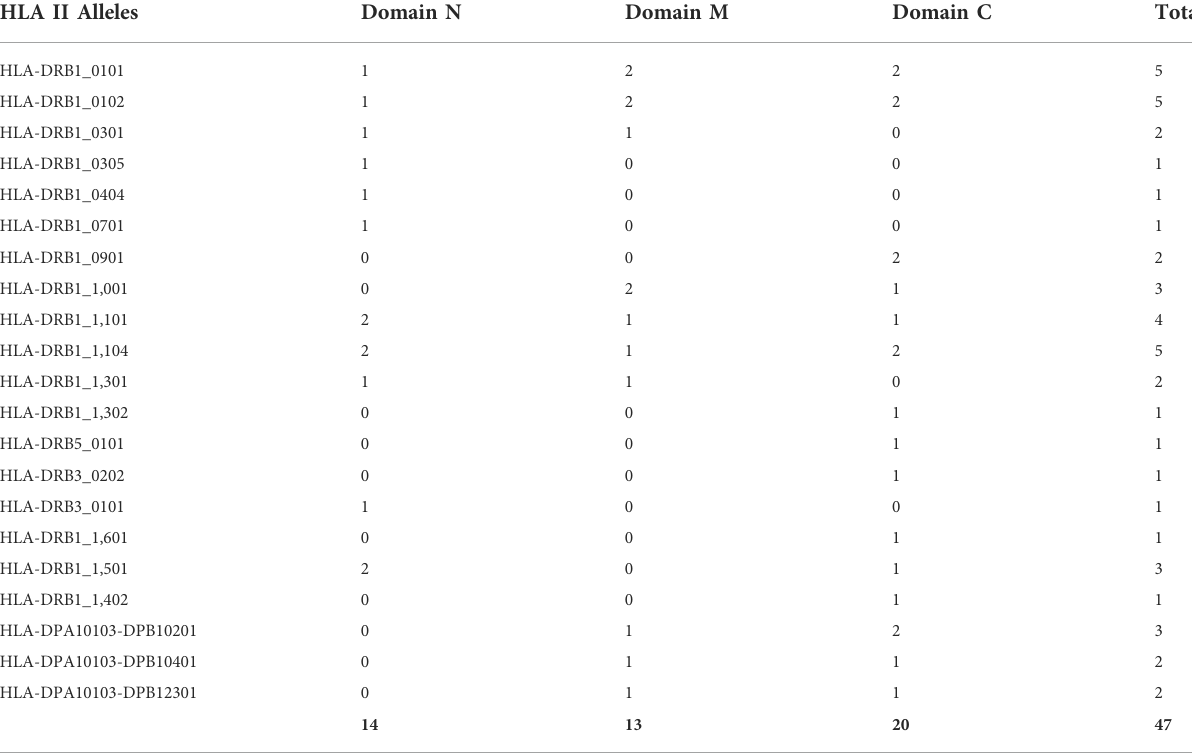
TABLE 2 Predicted number of strong binding MHC II epitopes, derived using NetMHCIIpan4.1 (IC50 cut-off of ≤ 50 nM). Epitope sequences are reported in Supplementary Table S3.